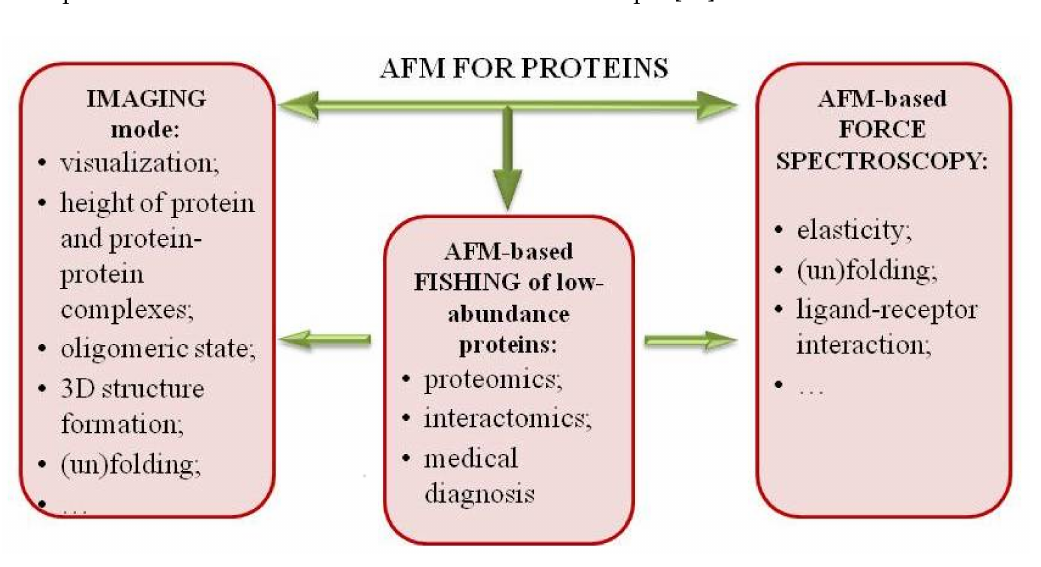
Figure 1. Application of atomic force microscopy (AFM) to study proteins. It includes three